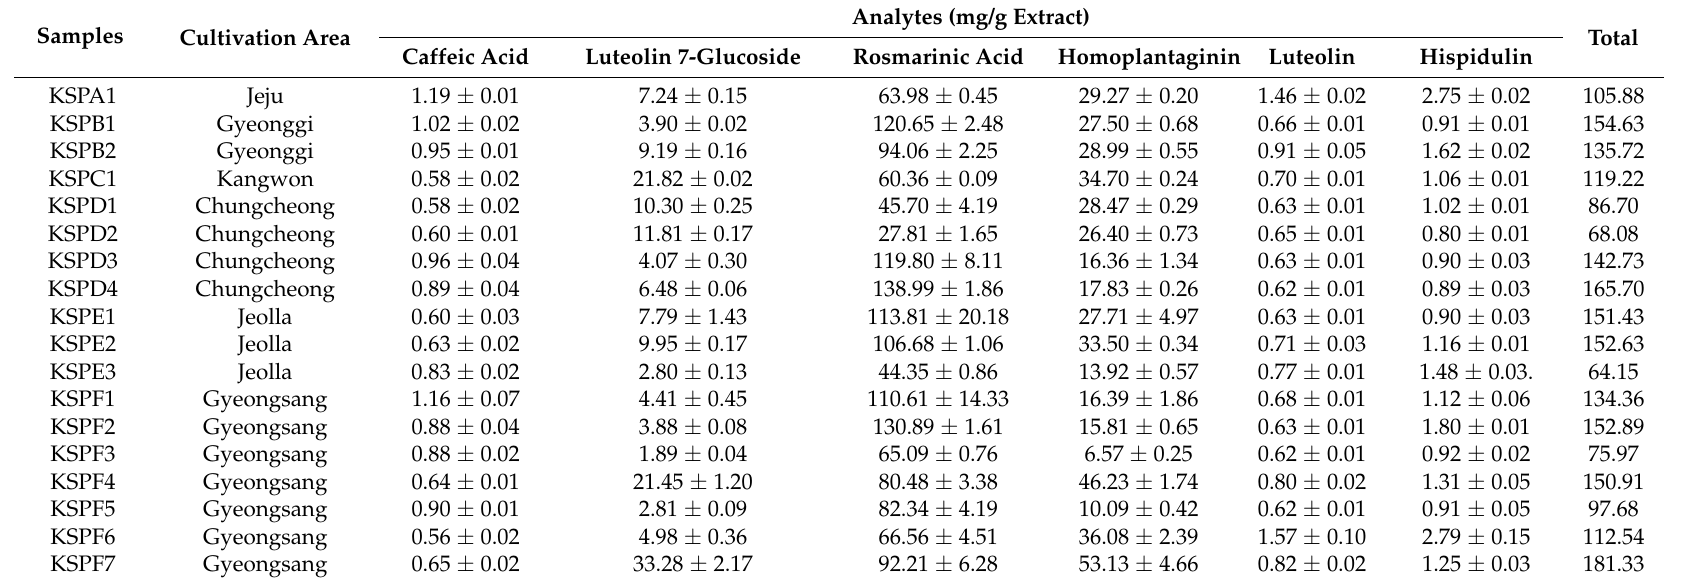
Table 1. Content of the phenolic and flavonoid compounds in the S. plebeia extracts in the different cultivation